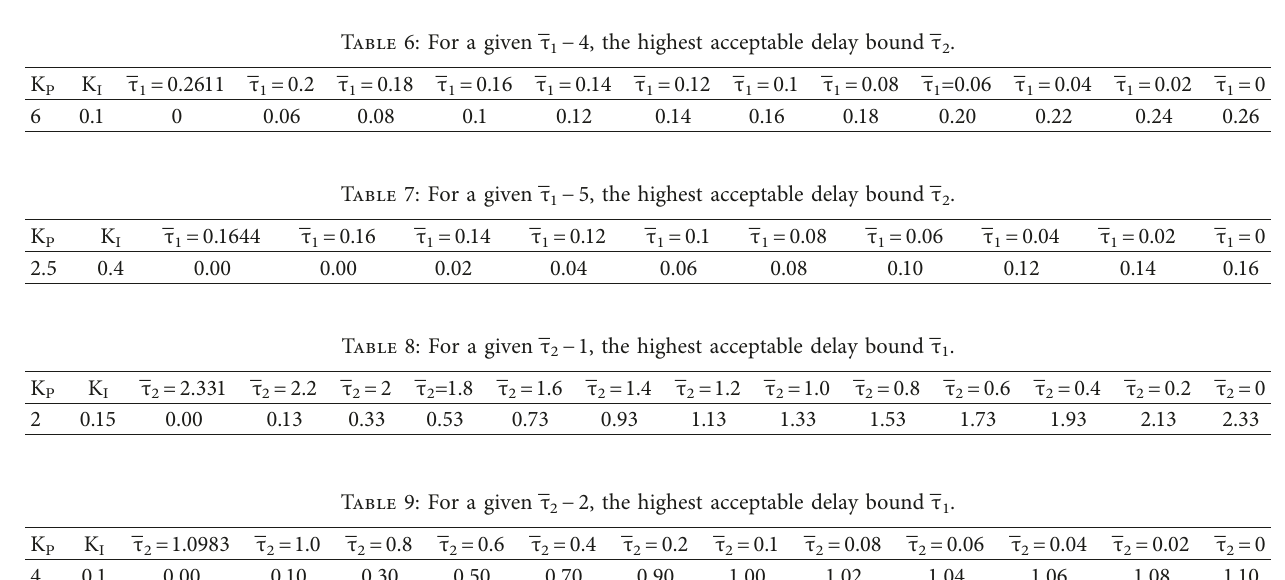
Table 6: For a given τ ̅